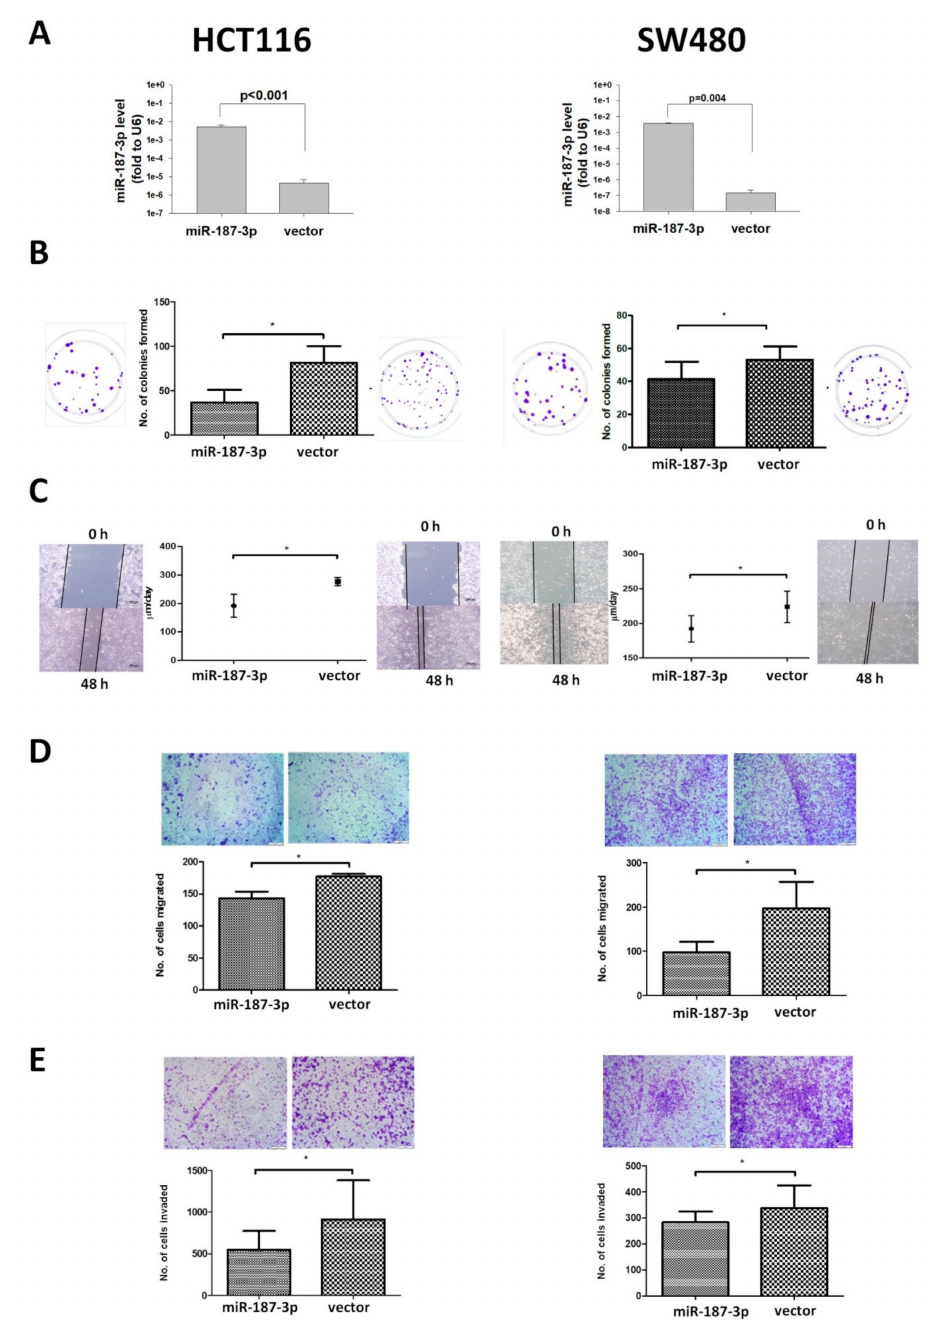
Figure 2. MiR-187-3p overexpression inhibited CRC cell migration and colony formation: ( A ) MiR- 187-3p plasmids or control vectors were stably overexpressed in HCT116 or SW480 cells. Quantitative PCR was performed to determine the expression of miR-187-3p in miR-187-3p or control vector clones. ( B ) Colony-formation assay was performed to compare the clonogenic ability of stable miR-187-3p and control vector HCT116 or SW480 cells. ( C ) Wound-healing assay was performed to compare the cell migration rates of stable HCT116 or SW480 cells with miR-187-3p or the control vector 48 h after wound creation. ( D ) Cell migration assay was performed to compare the migration ability of stable HCT116 or SW480 cells with miR-187-3p or the control vector. ( E ) Cell invasion assay was performed to compare the invasion ability of stable HCT116 or SW480 cells with miR-187-3p or the control vector. All experiments were performed in duplicate, and the data are expressed as the mean ± SEM of three independent experiments; * indicates that the difference is statistically significant ( p <